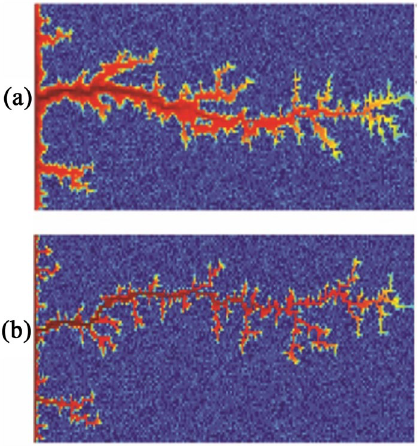
Fig. 10 Optimal patterns formed in two cases: a single phase and b two phase